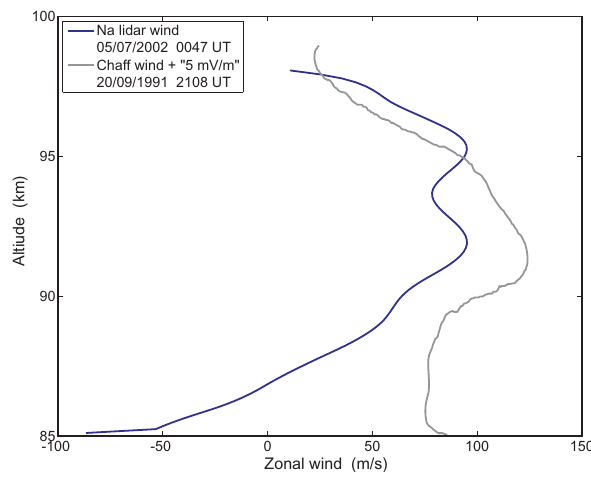
Fig. 3. Average of the zonal wind observed by the Na lidar for a one-hour interval centered around the time of the MaCWAVE rocket launch. The data for the gray line is taken from Kirkwood and von Zahn, 1993 and represents measured wind plus the effect of a 5mV/m southward electric field.